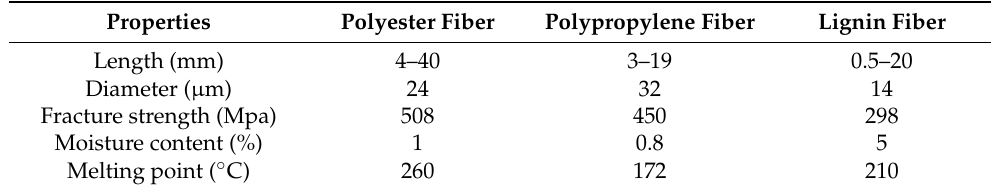
Table 4. General properties of the used fibers.